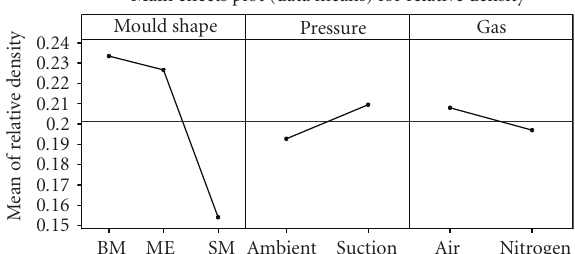
Figure 5: Main e ff ect plot for relative density.